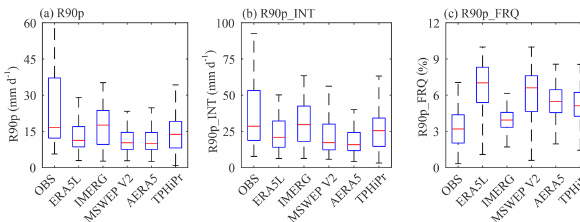
Figure 13. Similar to Fig. 11 but for extreme precipitation. The 90th percentile of observed daily precipitation at each rain gauge is taken as the threshold for calculating these metrics.